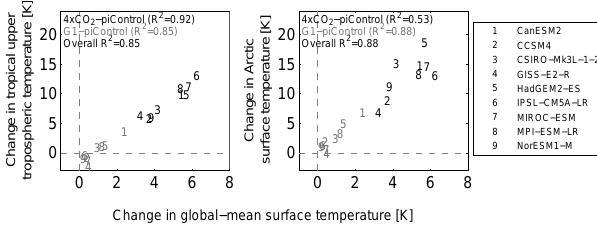
Figure 10. The change in tropical upper-tropospheric temperature versus the change in global-mean surface temperature (left), and the change in Arctic surface temperature versus the change in global- mean surface temperature (right), between the 4 × CO 2 and piCon- trol experiments (black) and between the G1 and piControl experi- ments (gray). Tropical upper-tropospheric temperature is defined as the mean temperature between 200 and 300hPa and between 10 ◦ S and 10 ◦ N. Arctic temperature is defined as the mean surface tem- perature between 75 and 90 ◦